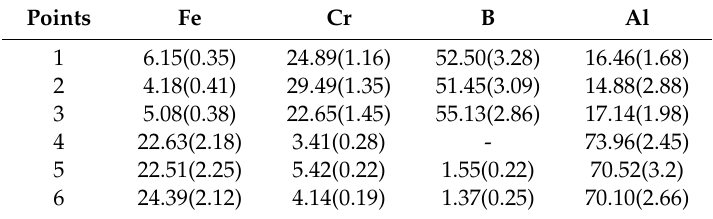
Figure 5. ( a ) The TEM micrograph of the periodic-layered structure (PLS). ( b ) The scanning transmission electron microscopy (STEM)-HADDAF micrograph of the PLS. ( c – f ) The elemental distribution of individual phases in the PLS. Table 3. The TEM-EDS results of the selected regions marked in Figure 5 (in at.%).